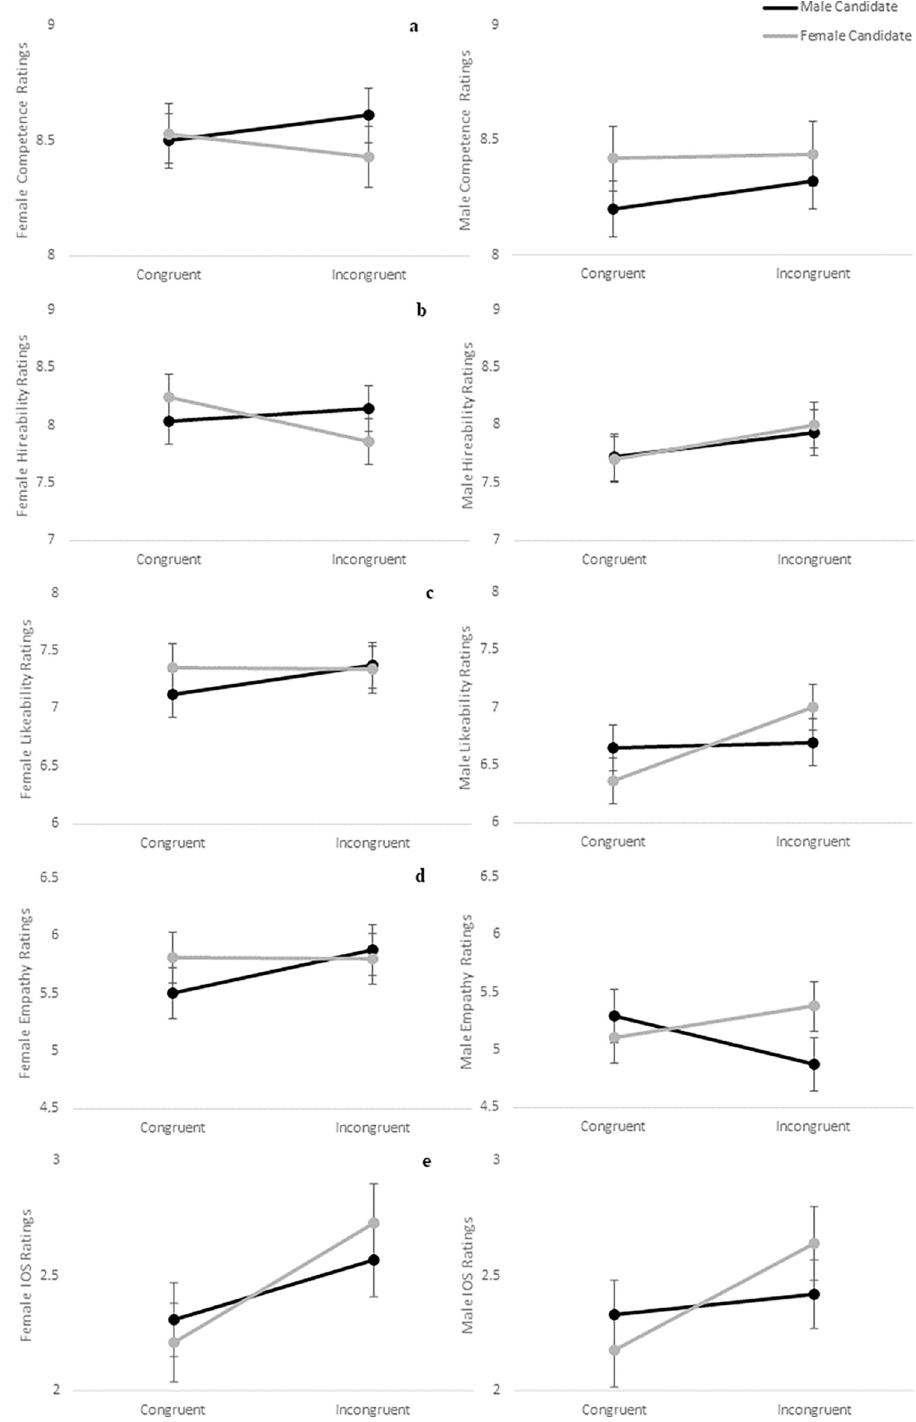
Fig 5. Candidate ratings following vr perspective taking. Comparison of female (left) and male (right) participant ratings by embodiment for the virtual candidates as illustrated for a) competence; b) hireability; c) likeability; d) empathy; e) interpersonal